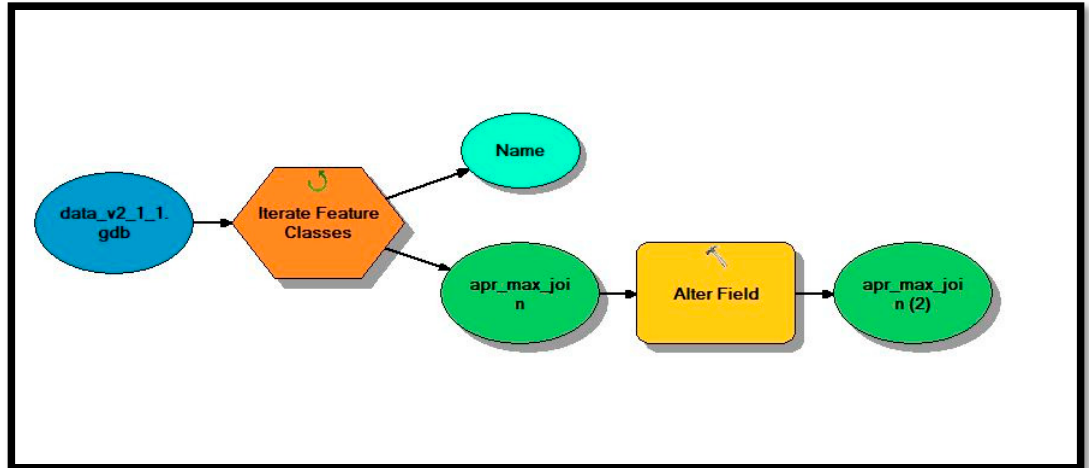
Figure 6. ArcMap ModelBuilder (Model 2) to rename the output field (contour field) from Model 1.